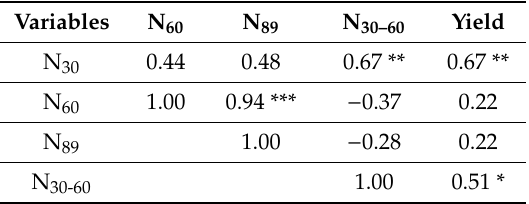
Figure S3. Principal components analysis (PCA) of nitrate N, available nutrients content and yield indices at WOSR ripening for (a) total NFS, (b) M-NFS, (c) O-NFS, (d) OM-NFS; NFS—nitrogen fertilization system; N89—nitrate N content at BBCH 89; P—phosphorus, K—potassium, Mg—magnesium, Ca—calcium; a, b, c—soil layers of